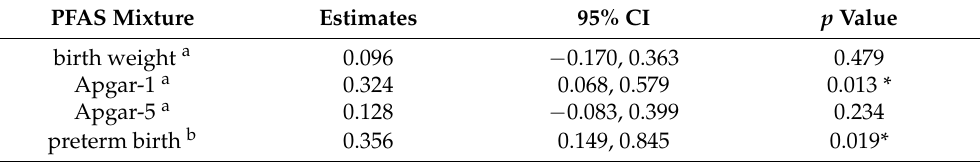
Table 3. Estimates and 95% CIs for quantile-based g-computation of PFASs on birth outcomes.